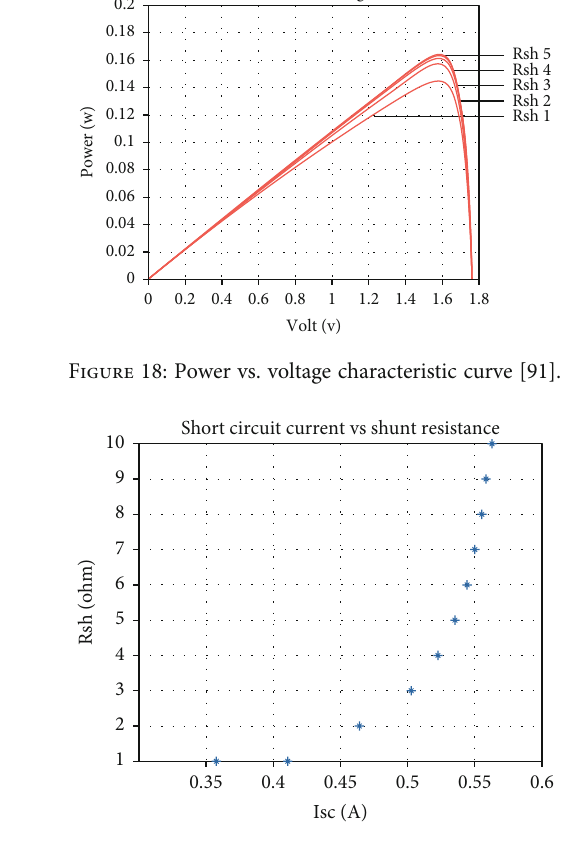
Figure 19: Short-circuit current vs. shunt resistance [91].